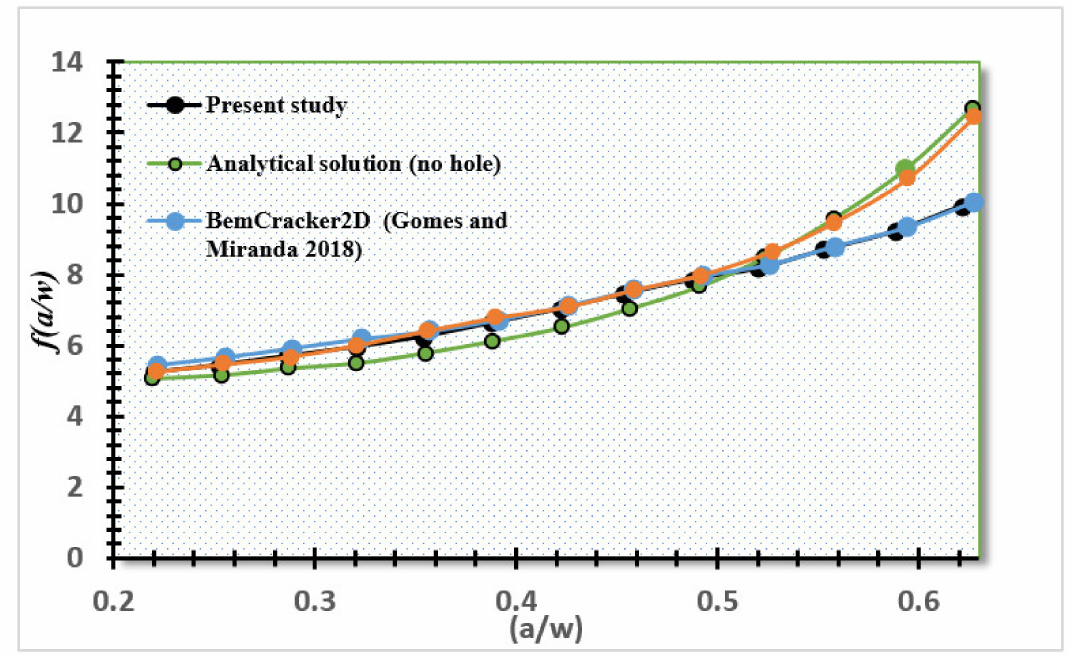
Figure 11. Dimensionless stress intensity factors (SIFs) of CTS01 compared to the analytical solution and the work of